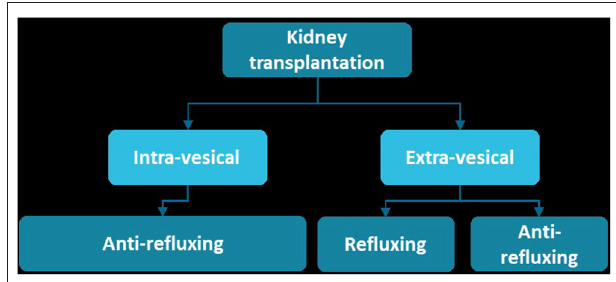
FIGURE 4 | Overview of different ureteroneocystostomy